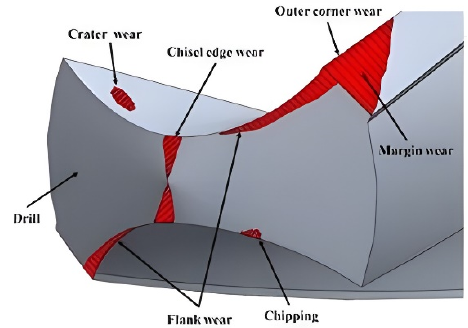
Figure 10. Types of wear on the drill [161].